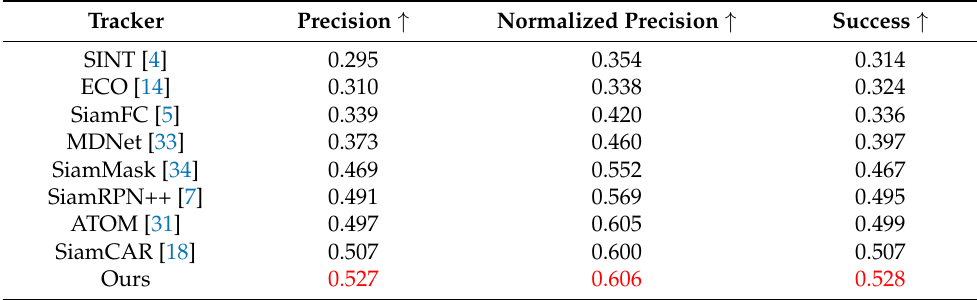
Table 1. Results on LaSOT benchmark. Red fonts indicate the top tracker ↑ . Indicates that the larger the parameter value, the better the tracker